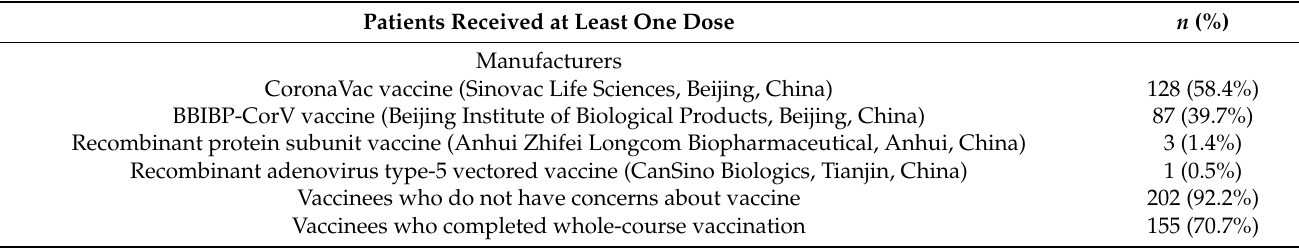
Table 3. The reasons for not becoming vaccinated in the unvaccinated PLWH ( n = 159). The Reasons for Not Having Been Vaccinated n (%) Concerns about side effects and/or poor efficacy 89 (56.0%) Waiting to be scheduled.